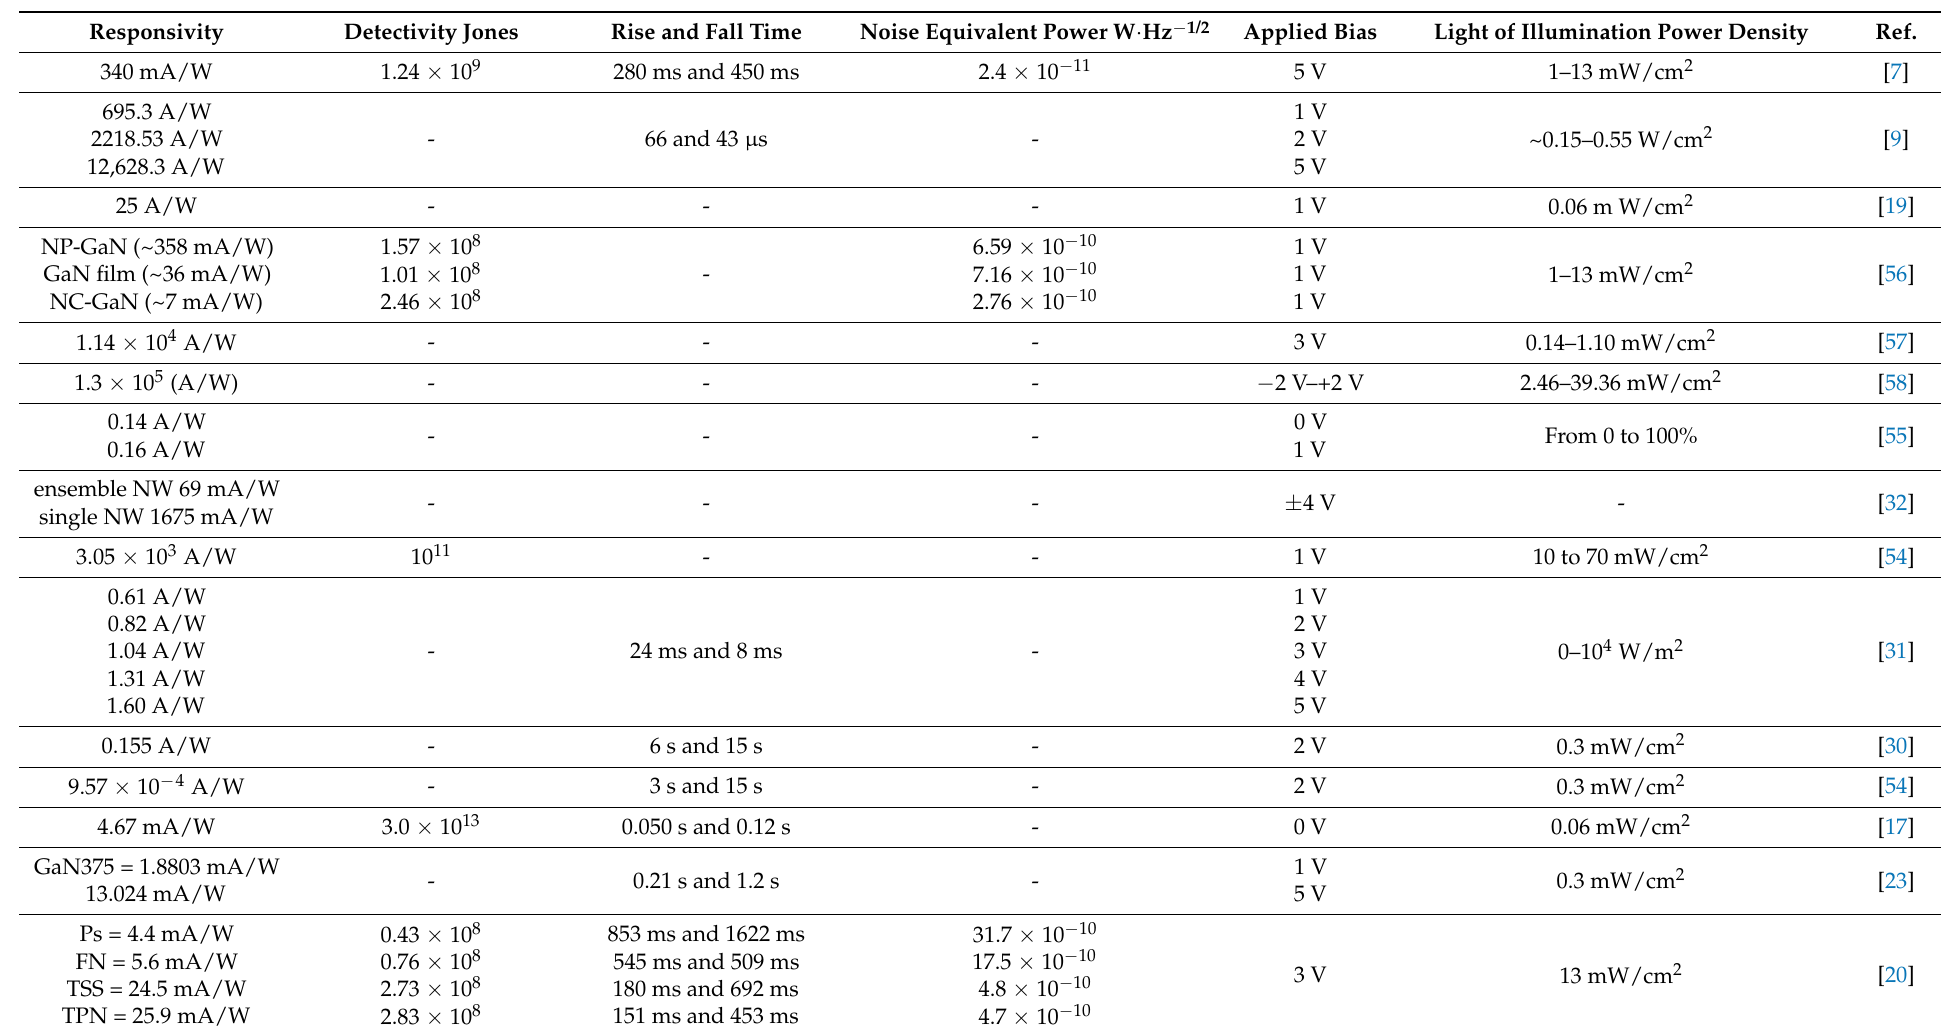
Table 2. Summary of electrical